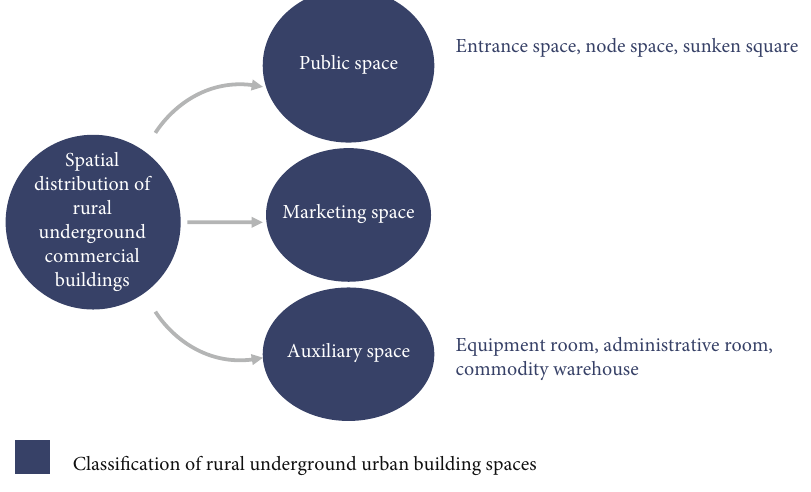
Figure 3: Classi fi cation of rural underground urban building spaces.